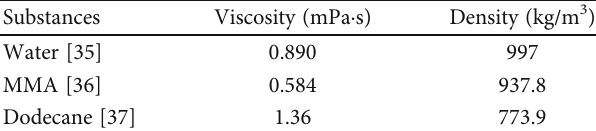
Table 3: Physical properties of the involved fl uids at 25 ° C. Substances